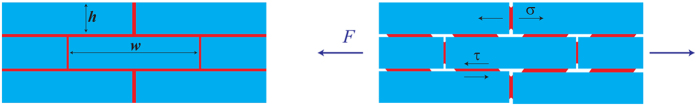
Schematic of a simple brick and mortar structure and its deformation under tension.In this case, the structure is symmetric and brick overlap corresponds to half its length.